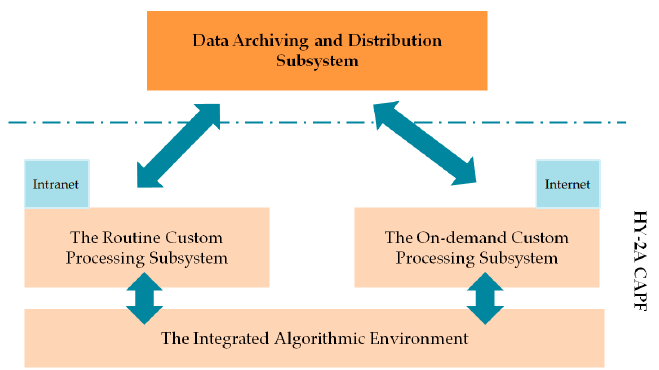
Figure 1. The components of the HY-2A Customized Automatic Processing Framework (CAPF).